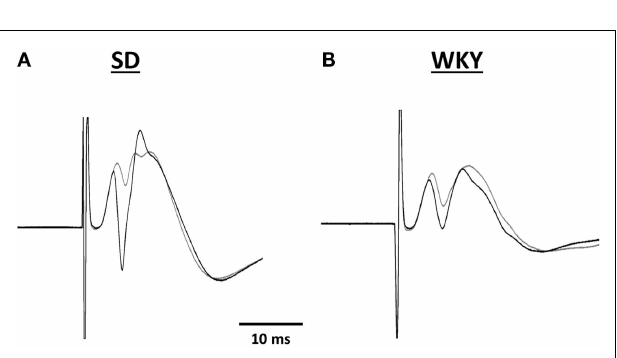
FIGURE 5 | Representative traces of evoked potentials recorded in the hilus of the dentate gyrus from SD (A) andWKY (B) rats . Evoked potentials were in response to stimulation of the medial perforant pathway before (gray line) and 180min after high frequency stimulation (black